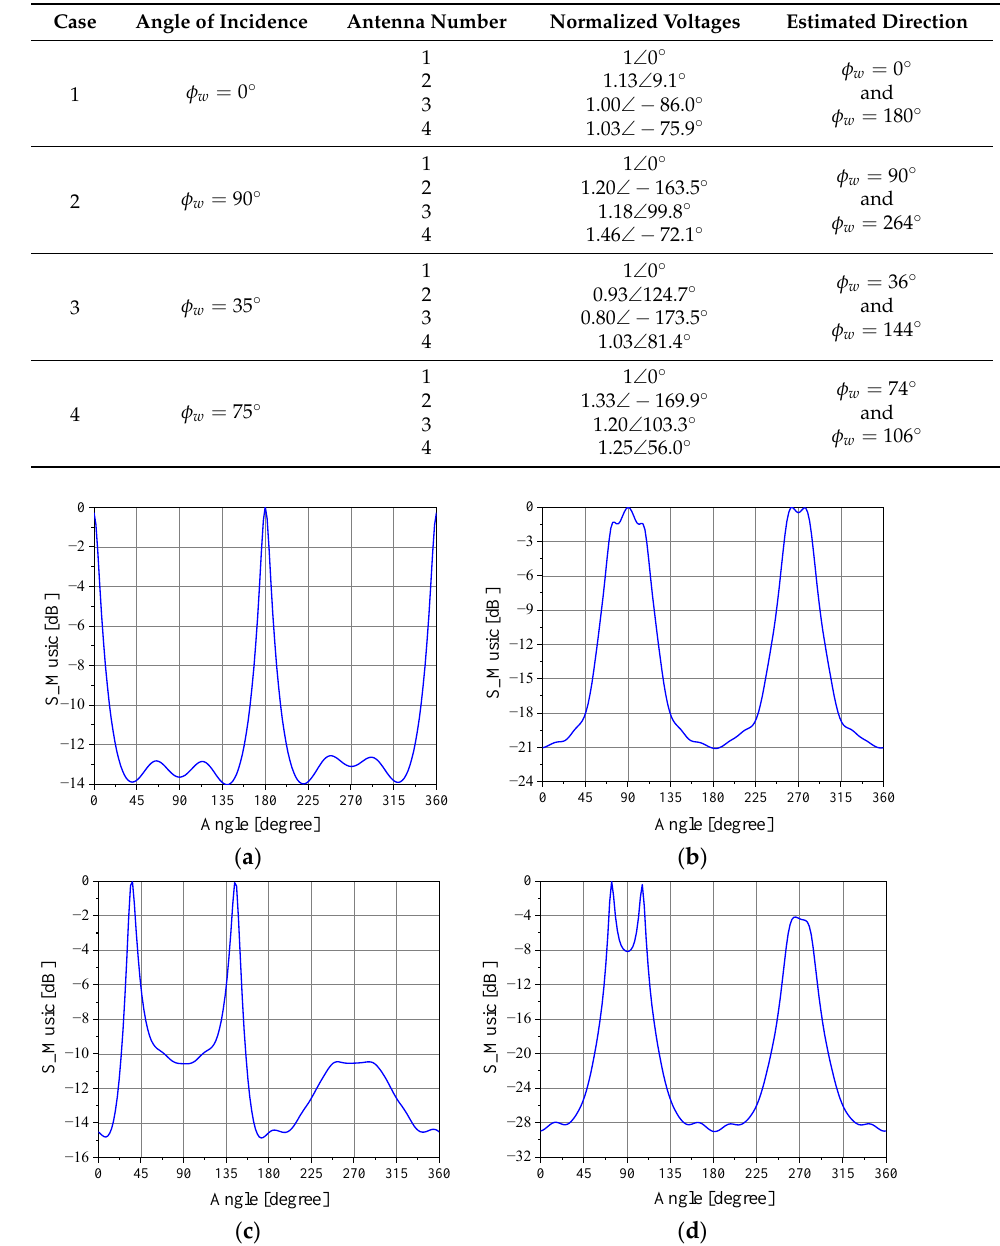
Table 4. Experimental results with the printed monopole array.